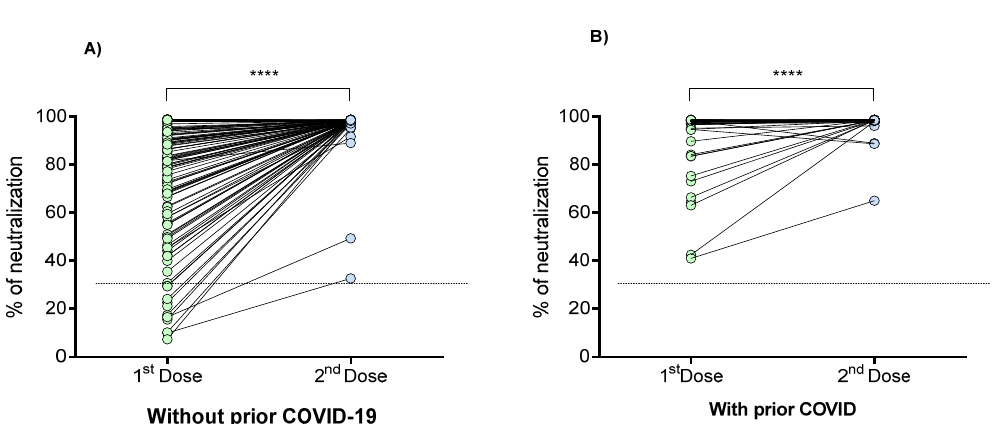
Figure 4. Percentage of neutralizing signal of antibodies generated in response to the BNT162b2 vaccine in individuals with and without prior COVID-19. ( A ) Individuals without prior COVID-19; ( B ) Individuals with prior COVID-19. Differences were calculated by the Wilcoxon signed-rank test. The dotted line indicates the cut-off point for the neutralization test (>30%). ****, p < 0.0001.